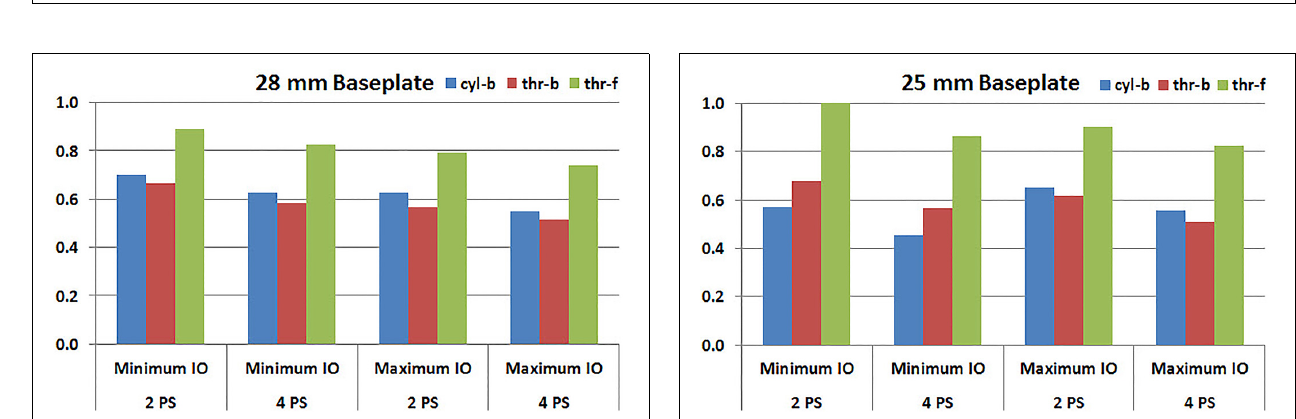
FIGURE 6 | (Left) FEA model of 25 mm baseplate implanted using 2 peripheral screws (view in sagittal plane); red and blue arrows showing resulting rocking motion. (Right) Interfacial normalized micromotion plot in distal view (results shown for configuration using thr-f screw-bone interface).